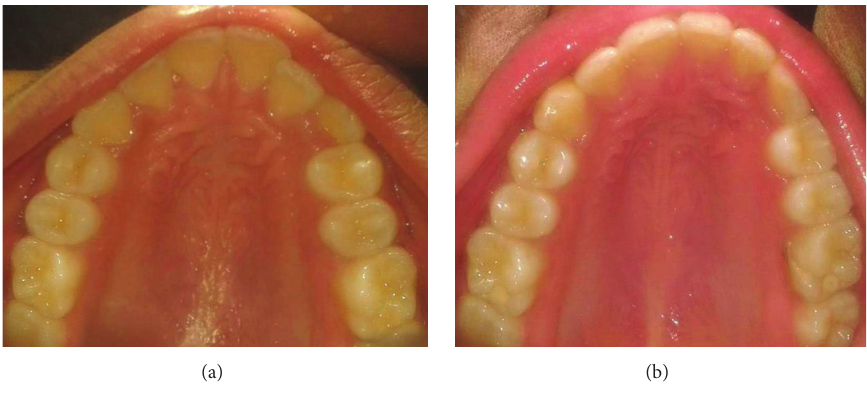
Figure 5: Pre- and postoperative occlusal